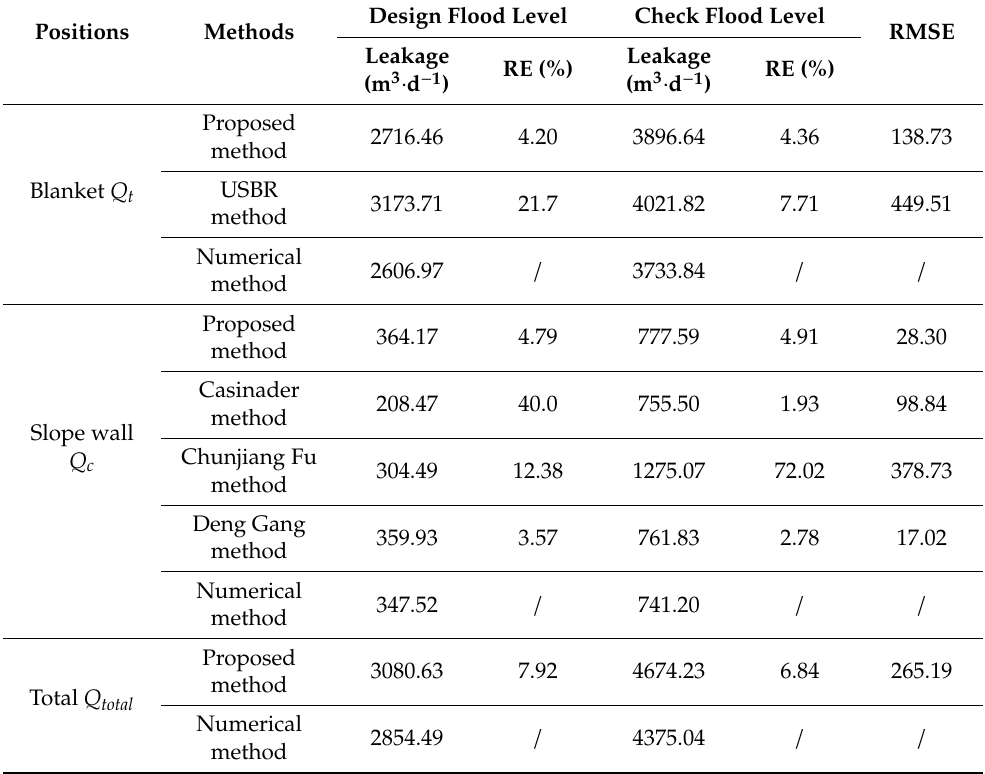
simulation for the Fukang composite geomembrane slope-wall rock-fill